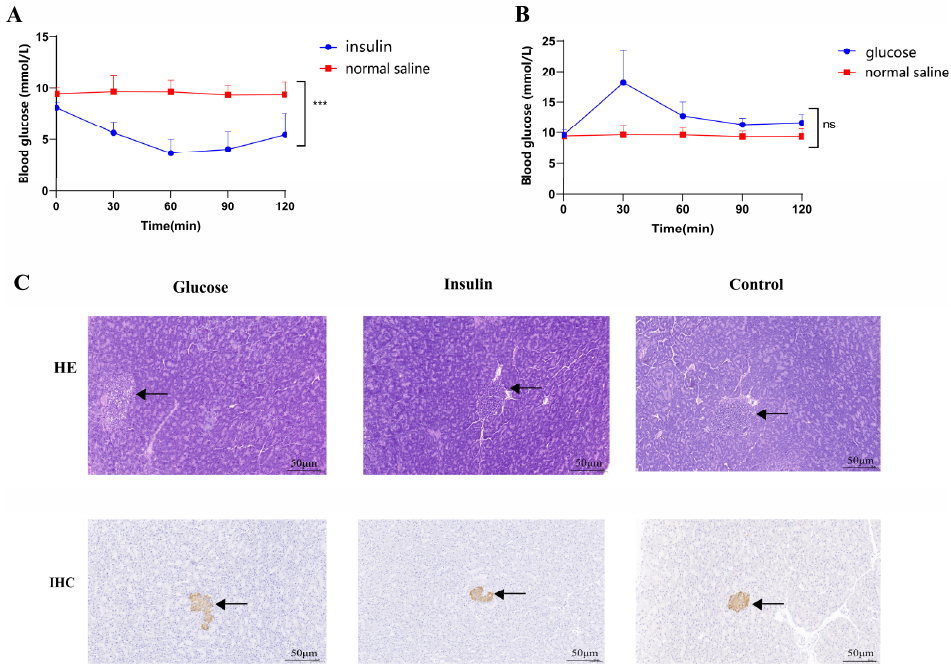
Figure 2. Acute hypoglycemia and hyperglycemia, induced by insulin/glucose, in chickens. ( A ) Acute hypoglycemic chickens using subcutaneous insulin injection (mmol/L). ( B ) Acute hyperglycemic chickens using oral glucose administration (mmol/L). ( C ) Morphology of pancreatic islets in different treatment groups stained with hematoxylin and eosin (HE) and β-cells were characterized by immunohistochemistry (IHC). Sections (5 μm) were cut from 4% paraformaldehyde-fixed tissue and treated with purified anti-mouse IRS1 antibody (Scale bar = 50 μm). The HE staining arrow refers to the morphology of the pancreatic islets, and the IHC arrow refers to the positive signal of the islet β cells (yellow). All values of ( A , B ) are mean ± SE n = 6 chickens per group, with *** p < 0.001, determined by one-way ANOVA. “ns” is “no